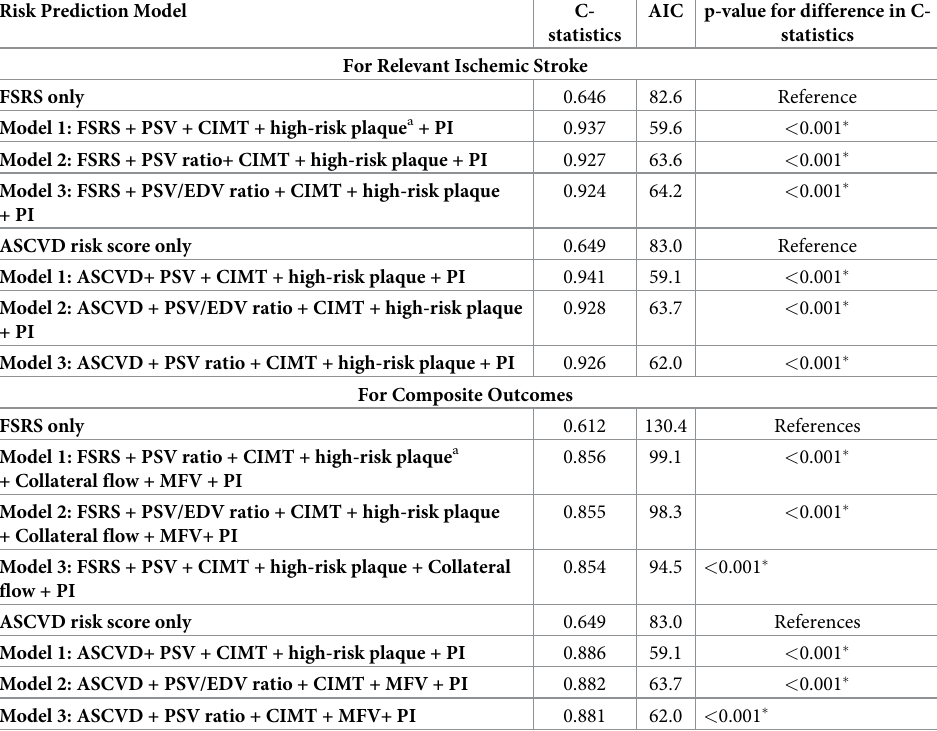
Table 3. Adjusted AUC for different prediction models with comparison to conventional risk scores only models.